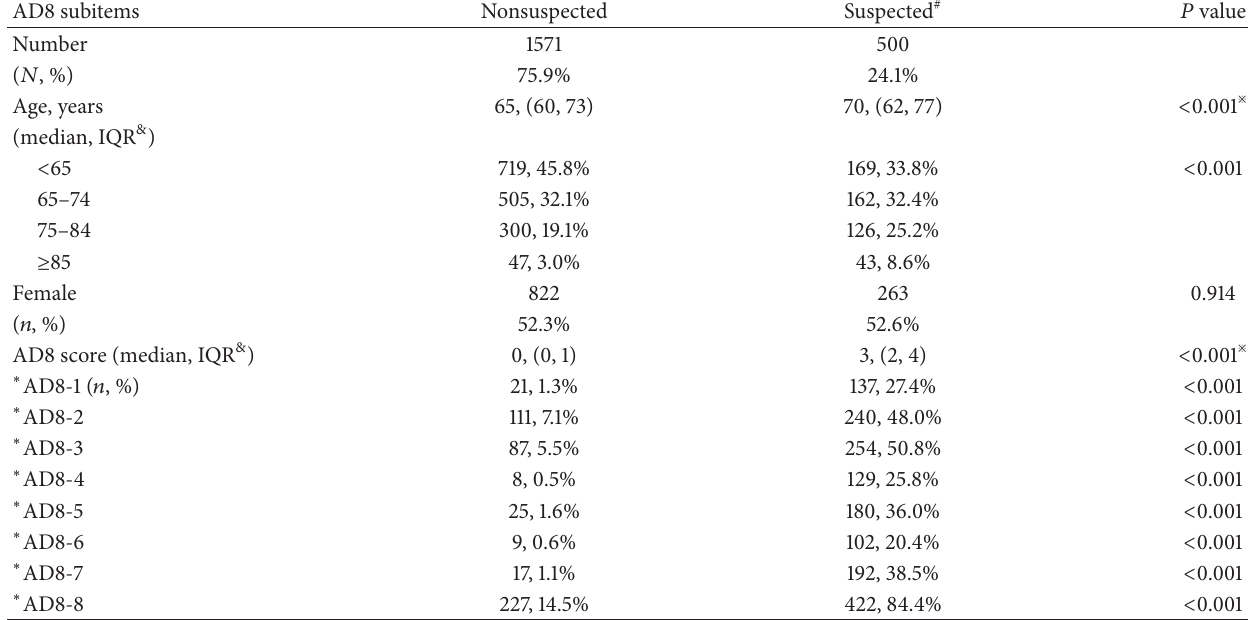
Table 2: AD8 subitems for the nonsuspected and suspected dementia